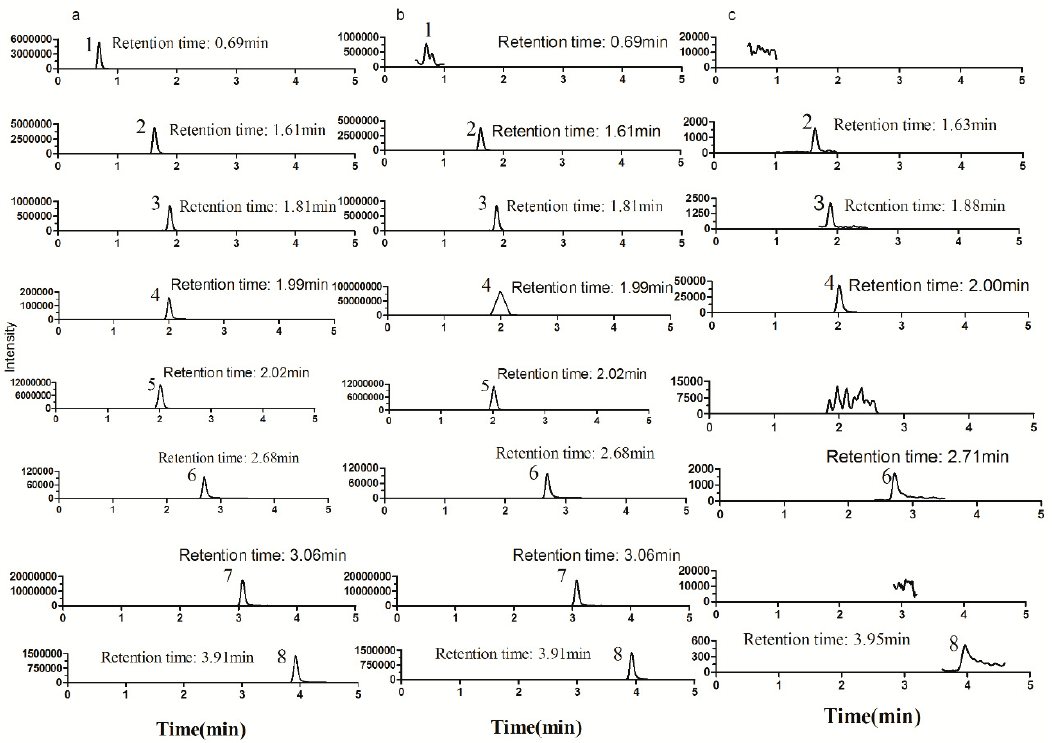
Figure 3. Typical full-scan product ion chromatograms of standard solutions ( a ), extract from crude samples ( b ), and cell lysates after incubation with Ch. majus for 30 min ( c ). Peak 1: magnoflorine; 2: protopine; 3: chelidonine; 4 coptisine; 5: allocryptopine; 6: sanguinarine; 7: berberine; 8: chelerythrine.